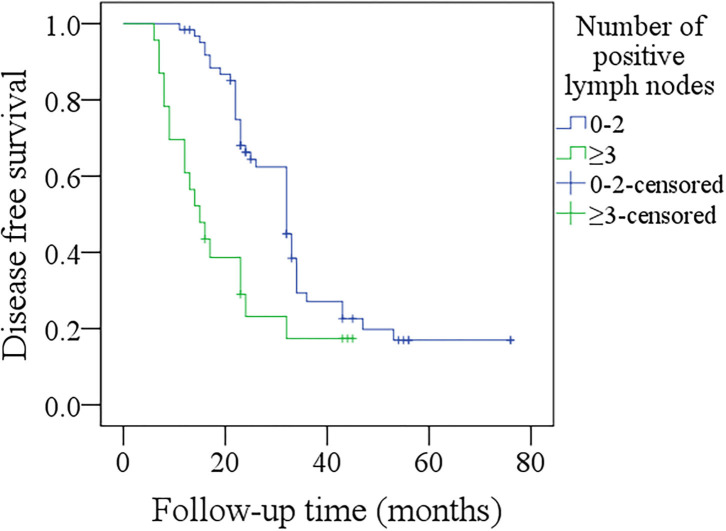
Comparison of disease-free survival among p16 positivity patients with different numbers of positive lymph nodes (p < 0.001).